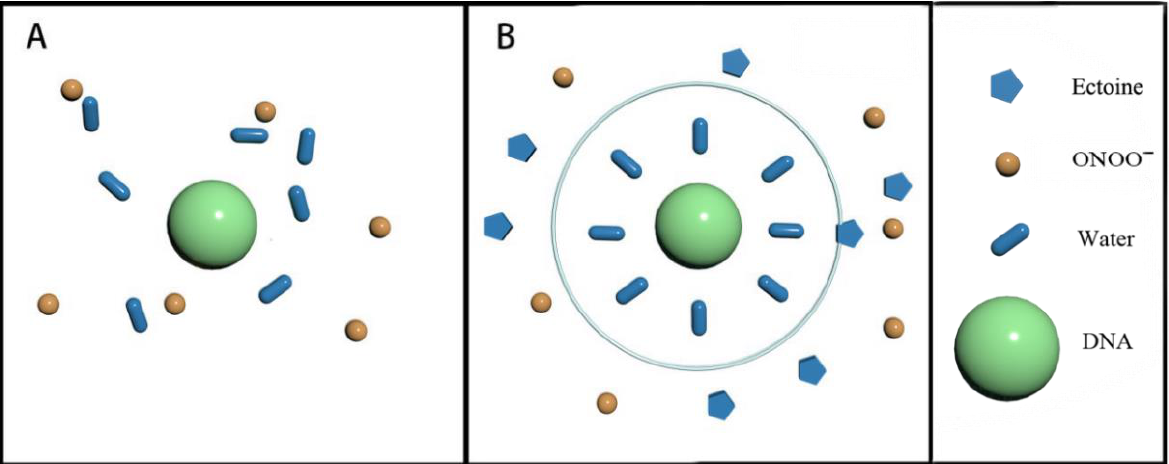
Figure 8. Schematic representation of interactions between DNA and ONOO − in ectoine solution. The central circle denotes DNA, blue oval as water, small orange circle as ONOO − , and pentagon as ectoine. ( A ) interactions between DNA and ONOO − ; ( B ) interactions between DNA and ONOO − in presence of ectoine.